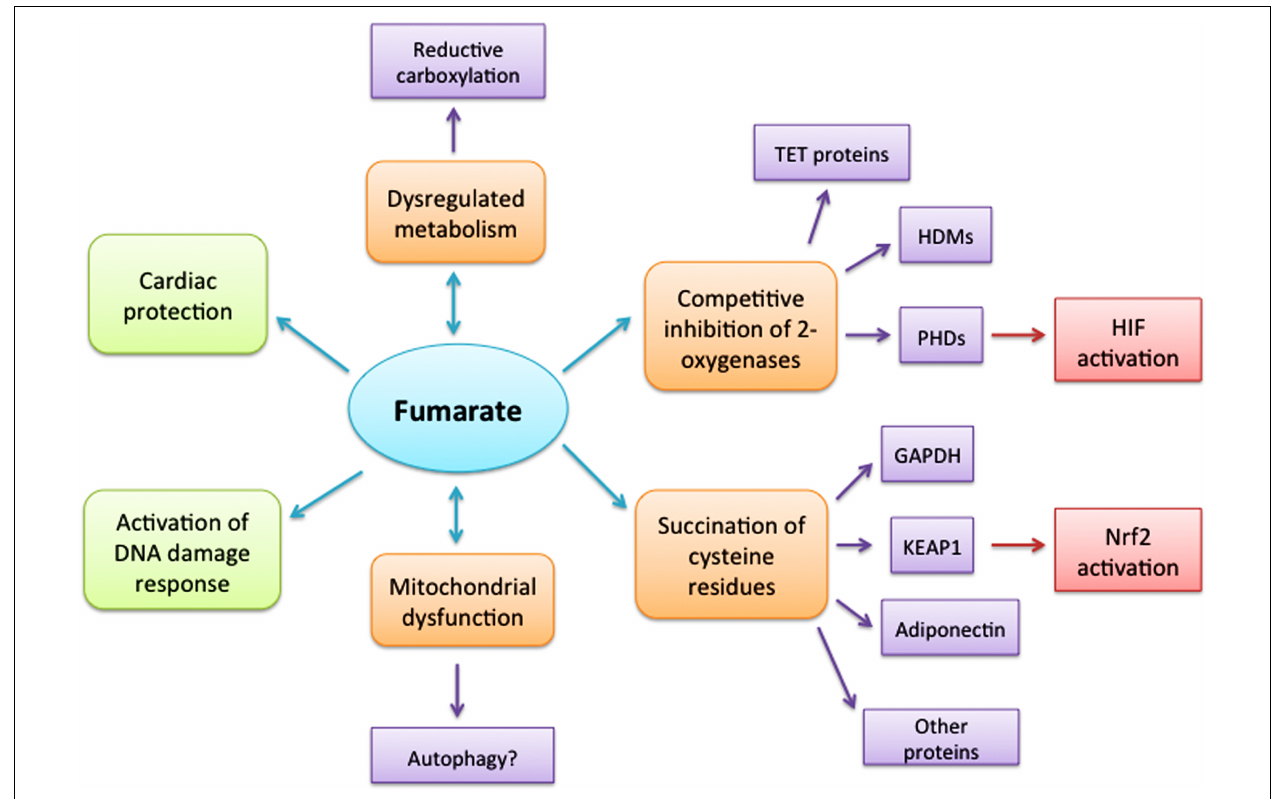
histone demethylase enzymes (HDMs),TET proteins and hypoxia-inducible factor (HIF) hydroxylases, thus activating oncogenic HIF pathways. However, further investigation is required to ascertain whether fumarate initiates oncogenesis via all, or any, of these routes. Succination of cysteine residues that could lead to disruption or loss of protein functions, dysfunctional cell metabolism and cell signaling offers a novel and promising route to link fumarate and oncogenesis directly.The benefits of fumarate proposed in activating a DNA damage response need to be addressed further, while the cytoprotective role proposed for fumarate in cardiac cells by diverting amino acids into the Krebs cycle and activating the Nrf2 antioxidant pathway suggests that different cell types may have different response